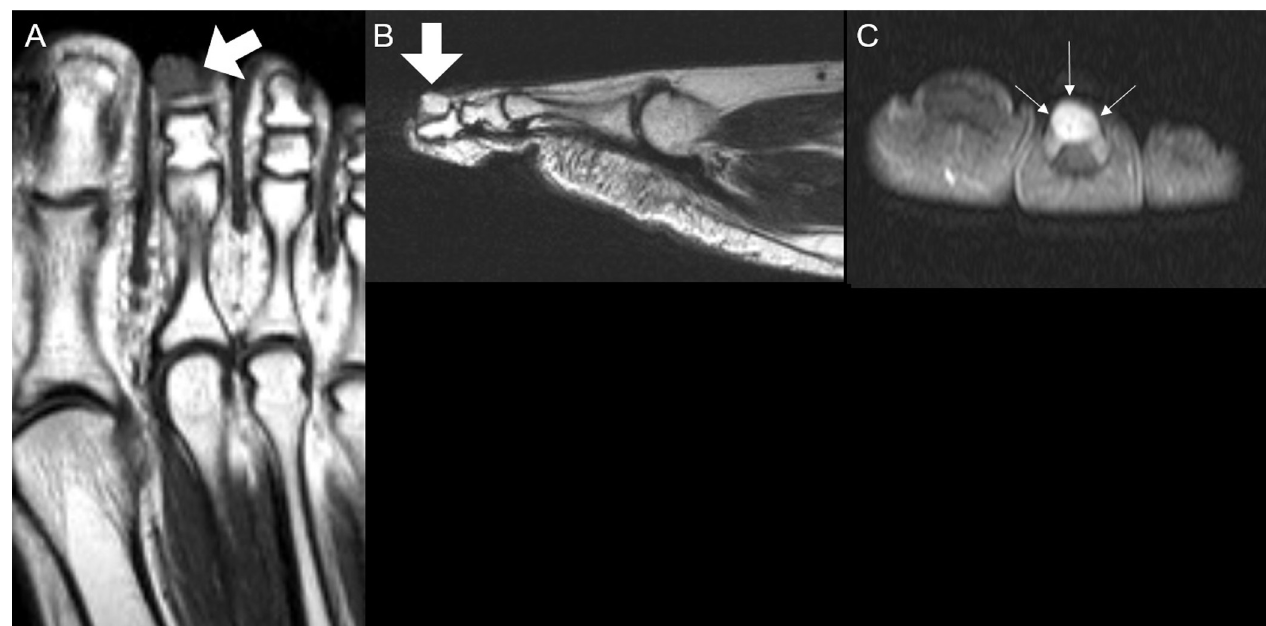
Fig 6. A 31-year-old woman with digital schwannoma in the subungual area of the 2 nd toe. ( A) On coronal T1-weighted image, the mass demonstrates mild hyperintense SI compared to skeletal muscle (arrow). ( B) On sagittal T2-weighted image, the mass reveals homogeneously hyperintense SI compared to skeletal muscle (arrow). ( C) On axial contrast-enhanced T1-weighted image, the mass demonstrates homogeneous enhancement with displacement of the nail plate (thin arrows). SI , signal intensity.